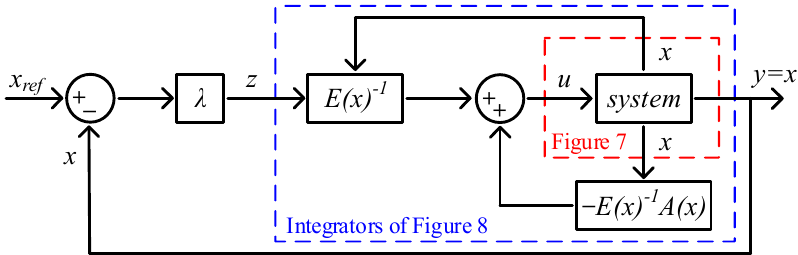
Figure 8. Linear decoupled model of the 5-switch converter.